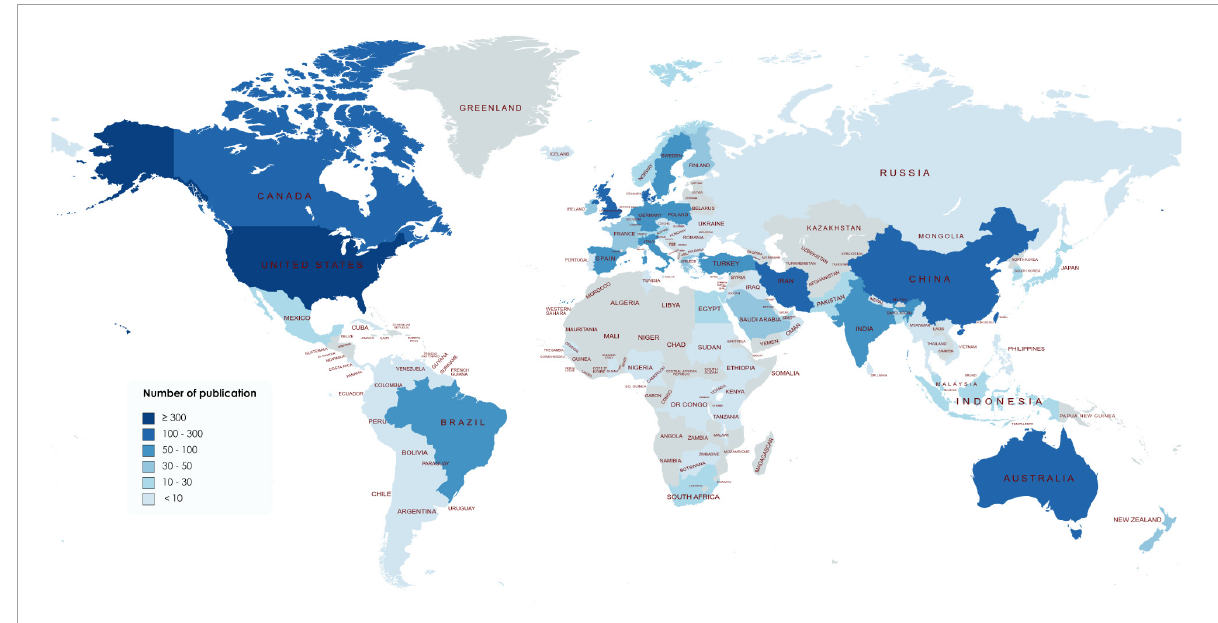
FIGURE2 World map of countries contributing to vitamin D and reproductive health.